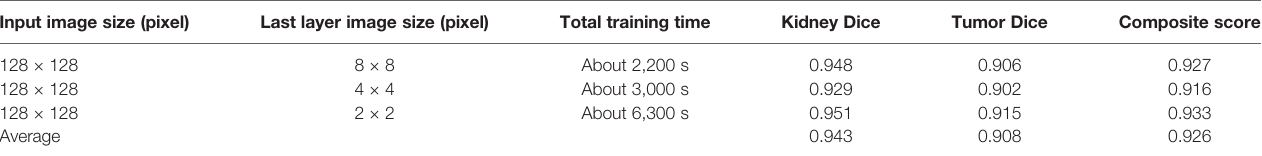
TABLE 3 | Fine segmentation based on FR2PAttU-Net model (parallel convolutions [convolution kernel = 3 × 3)].